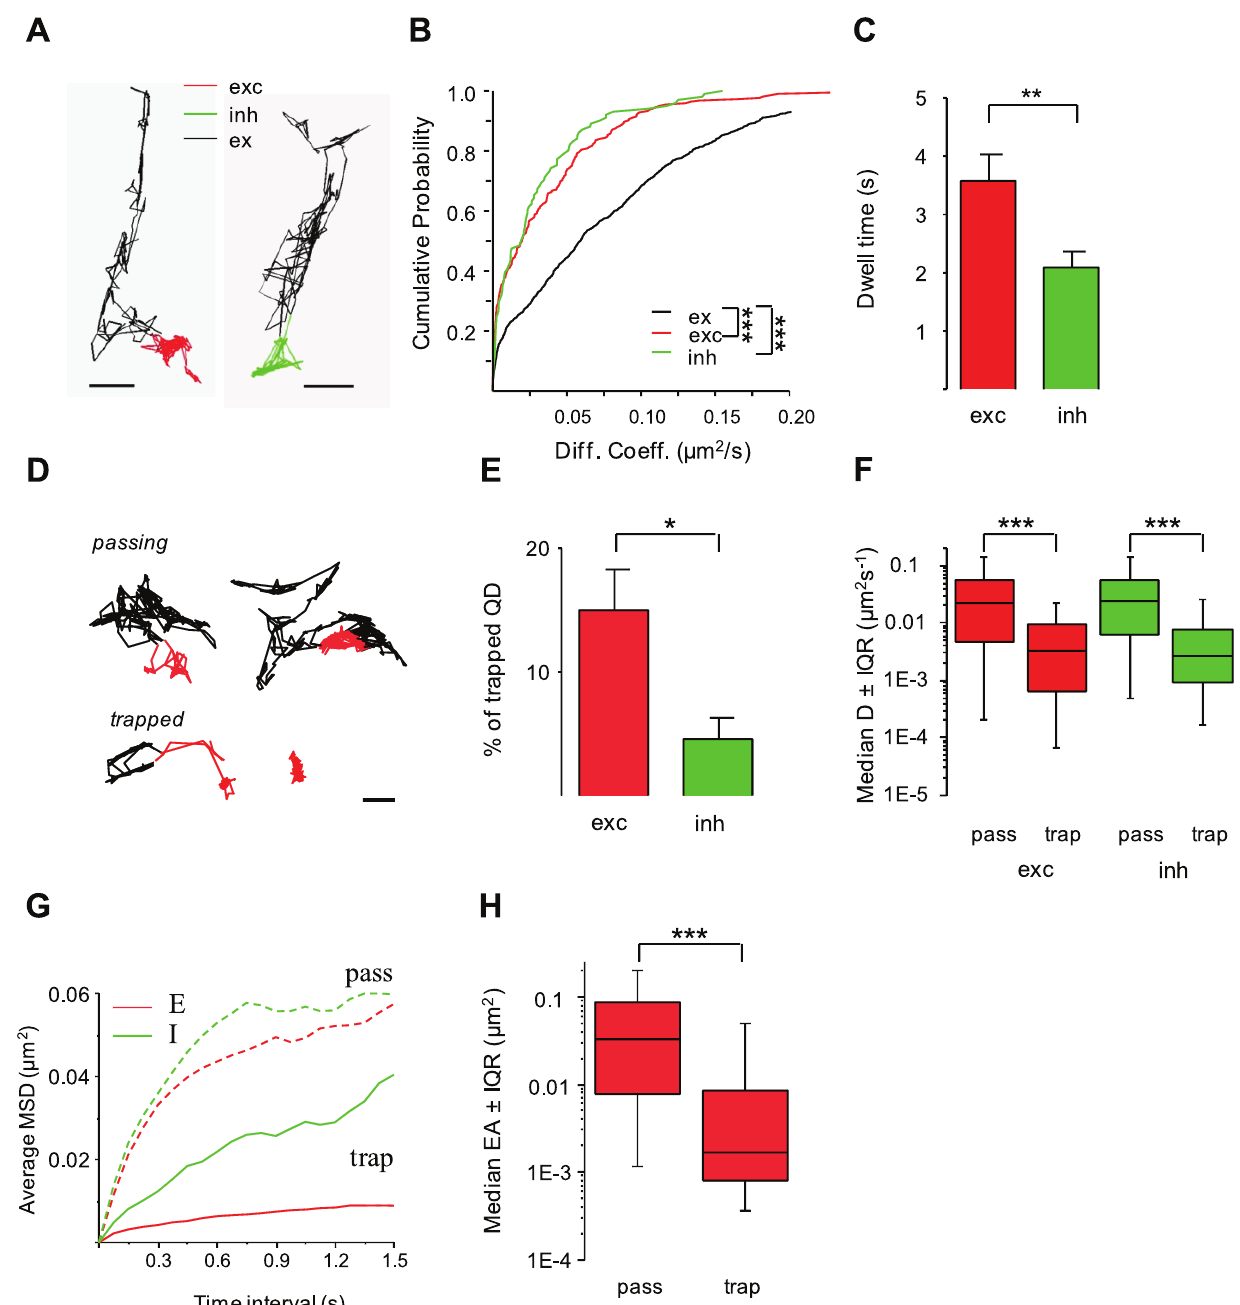
Figure 7. Diffusion characteristics of the GluA2 subunit of the AMPAR in inhibitory and excitatory synapses. (A) Trajectories of GluA2- coupled QDs in excitatory (red), inhibitory (green) synapses or in extrasynaptic compartment (black). Scale, 0.4 m m. (B) Cumulative probabilities of diffusion coefficients of GluA2 in inhibitory (green) and excitatory synapses (red) vs . the extrasynaptic membrane (black) (KS test, ***p , 10 2 3 ). (C) Dwell time (mean 6 SEM) of GluA2 in excitatory (exc, red) or inhibitory (inh, green) synapses (t test **p , 10 2 2 ). (D) Representative examples of trajectories for passing (top) and trapped (bottom) receptors outside (black) or inside (red) excitatory synapses. Scale, 0.3 m m. (E) Increased proportion (mean 6 SEM) of trapped GluA2-coupled QDs in excitatory (exc, red) vs . inhibitory (inh, green) synapses (t test, *p , 5 6 10 2 2 ). (F) Reduced mobility (median D 6 25%-75% IQR; KS test, ***p , 10 2 3 ) for trapped (trap) receptors in excitatory (exc, red) and inhibitory (inh, green) synapses vs . passing ones (pass). (G) Averaged MSD vs . time relation for passing (broken line) or trapped (plain line) GluA2 in excitatory (red) or inhibitory (green) synapses. (H) Explored area (median EA 6 25%–75% IQR) for trapped (trap) receptors at excitatory synapses (exc, red) (KS test, ***p , 10 2 3 ). doi:10.1371/journal.pone.0043032.g007 performed two days after transfection. A plasmid equimolar ratio Immunocytochemistry of cDNA was used in all cotransfection experiments. Cells were fixed for 15 min with paraformaldehyde (4% w/v, Serva Feinbiochemica, Heidelberg, Germany) in PBS containing